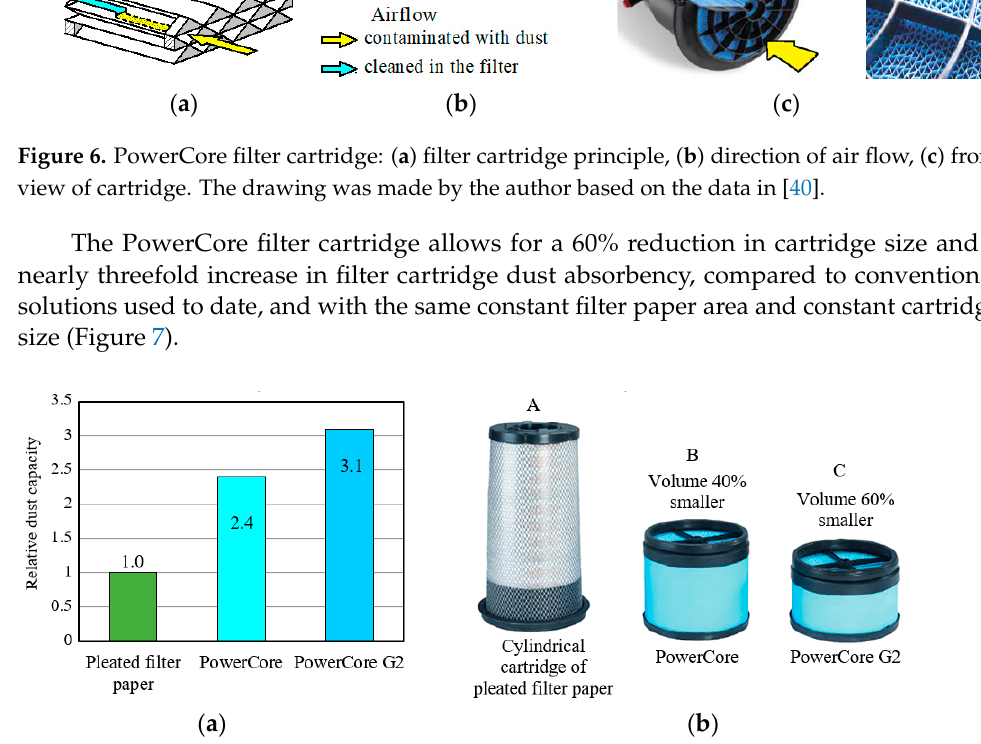
Figure 7. Comparison of PowerCore cartridges with respect to traditional (filter paper) filter media: ( a ) relative dust capacity, ( b ) occupied volume. The drawing was made by the author based on the data in [41].